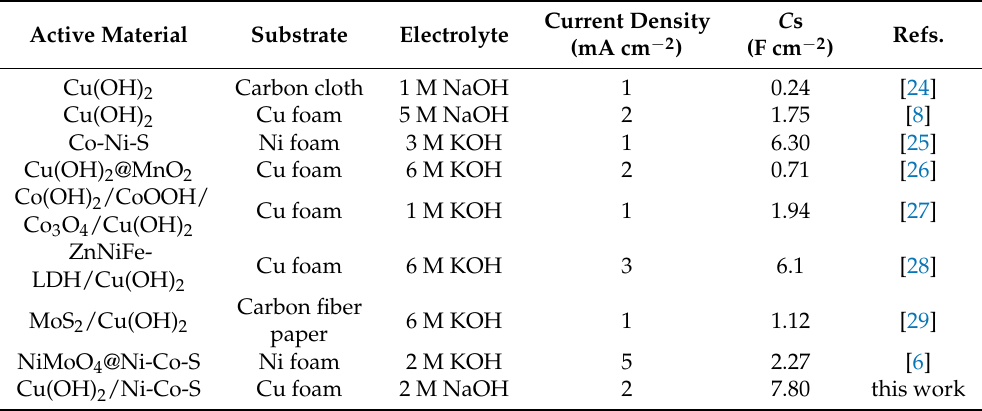
Table 1 lists the relevant Cu(OH) 2 and TMS electrodes reported in recent literature. Table 1. Comparison of C s between Cu(OH) 2 /NCS and literature reports. Active